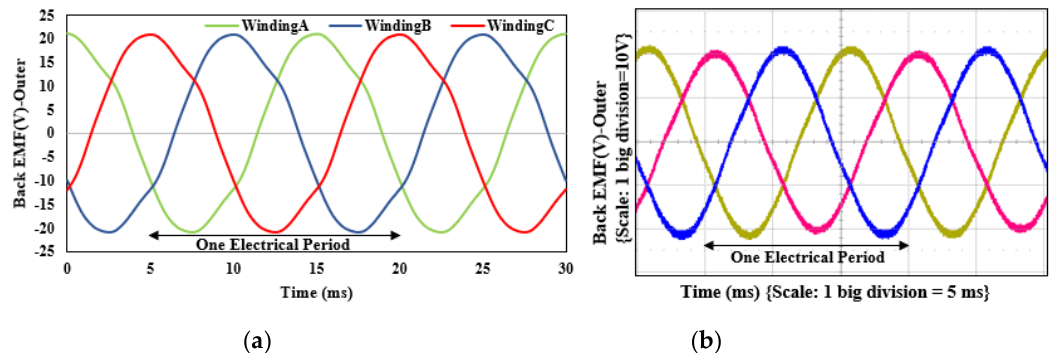
Figure 17. Back EMF comparison-outer stator: ( a ) 2D-FEM simulation, ( b ) prototype experiment.